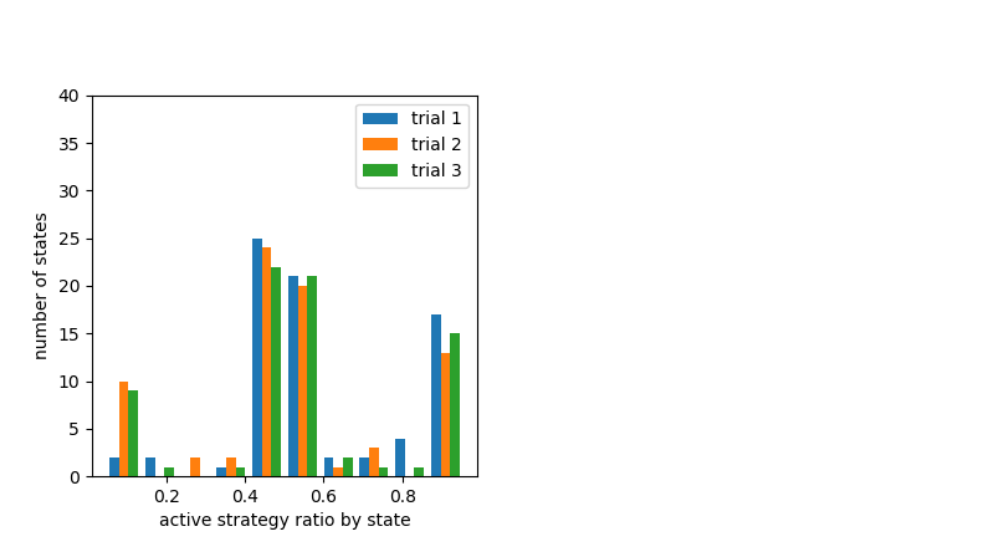
Figure 12. Percentage of active strategies chosen by state (cooperative rewards (2, 1), after active strategy is effective).